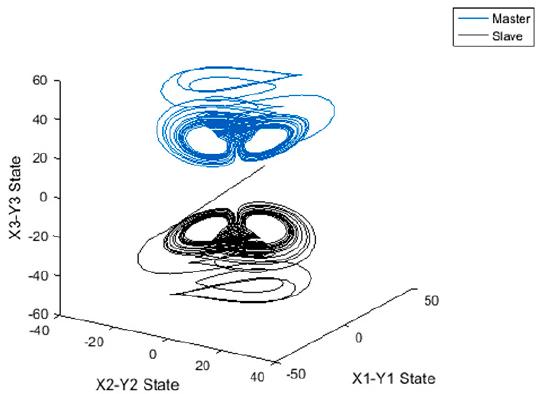
Figure 8. Phase space of anti-synchronization of an original master–slave system.